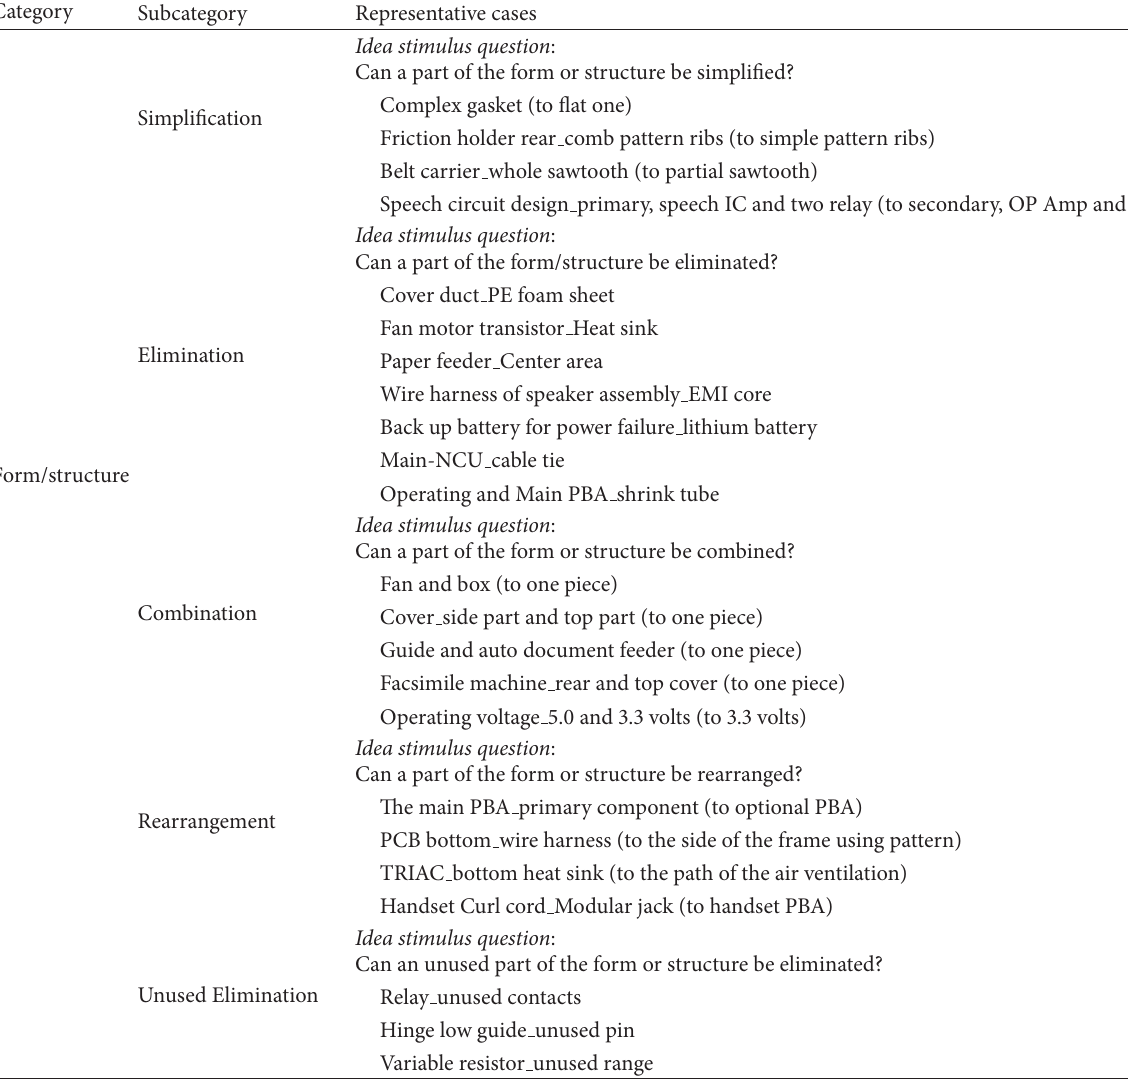
Table 2: Form/structure checklist and representative